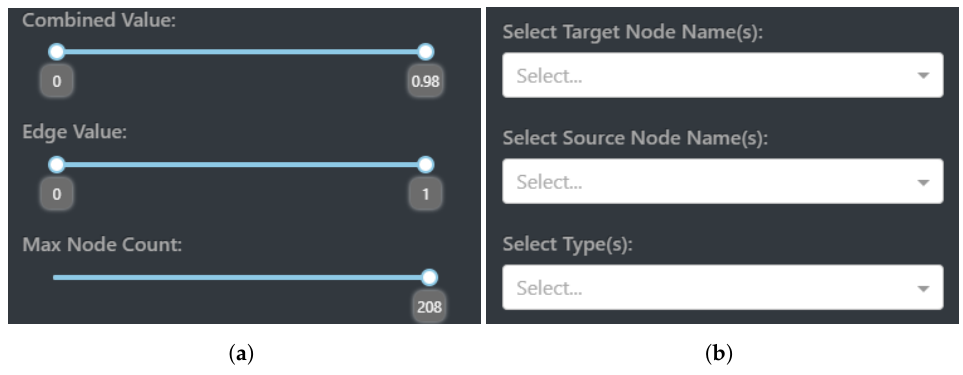
Figure 6. Value filtering as well as node and type filtering settings as displayed by CompositeView. ( a ) Value filtering sliders. ( b ) Node and edge filtering